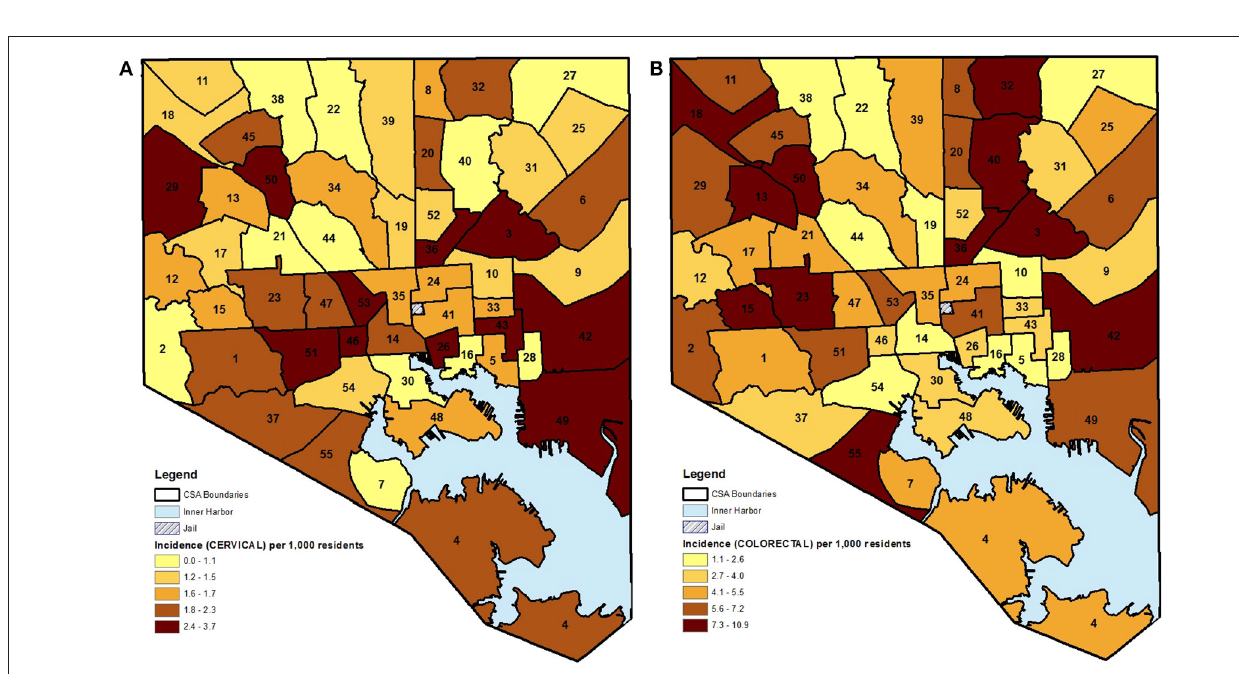
FIGURE 2 | (A,B) CSA distribution shaded by quintile of female cancer incidence (cervical and colorectal) in Baltimore City, MD per 1,000 female residents aged 21–74 years, 2000–2010. (See Supplemental Table 1 for key to CSA ID numbers).